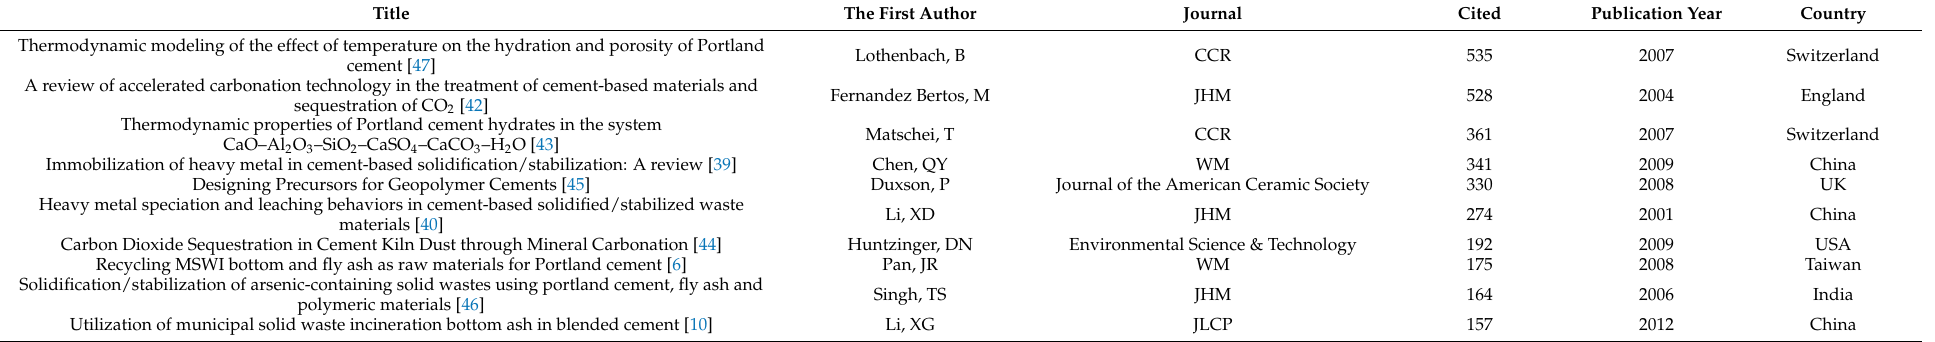
Table 5. The statistics of the top ten most cited